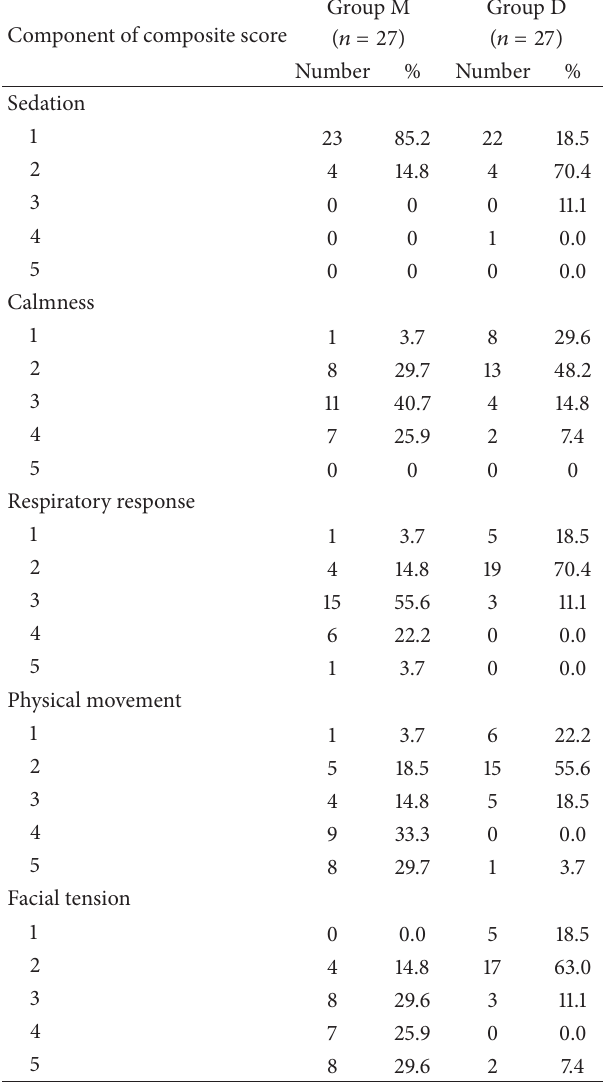
Table 4: Split-up of components of the composite score. Component of composite